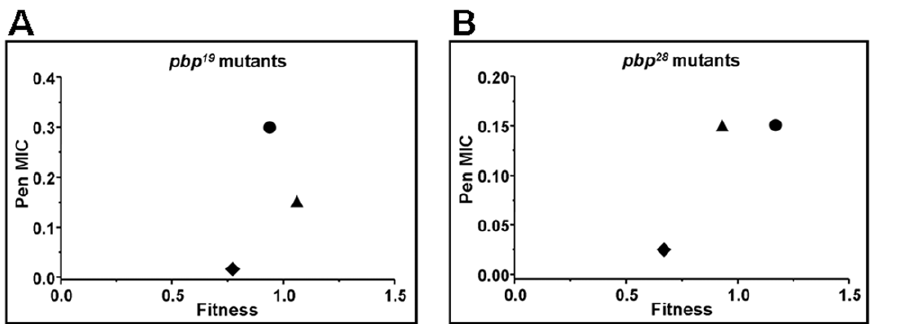
Figure 1. Correlation plot between the fitness value of pbp mutants, obtained by using pbp genes from Cba-19 and Cba-28 clinical strains, and the penicillin MIC increase found ( m g/ml). A) Correlation for Cp1015 pbp 19 mutants, Cp1015 pbp2b 19 (diamonds), Cp1015 pbp2b 19 pbp2x 19 (triangles), and Cp1015 pbp2b 19 pbp1a 19 pbp2x 19 (circles). B) Correlation for Cp1015 pbp 28 mutants, Cp1015 pbp2b 28 (diamonds), Cp1015 pbp2b 28 pbp2x 28 (triangles), and Cp1015 pbp2b 28 pbp2x 28 pbp1a 28 (circles).